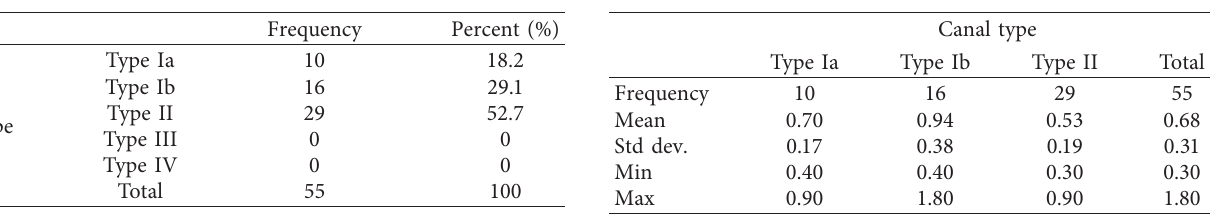
Figure 3: Some of the canals found in this study. (a), (b) Type Ia canals in two patients. Note the complicated relationship of the canal and third molar root in A. (c), (d) Two type Ib canals in two patients. (e), (f) Type II canals in two patients. Table 1: Relative incidence of retromolar canal types. Table 2: Mean diameter of different retromolar canal